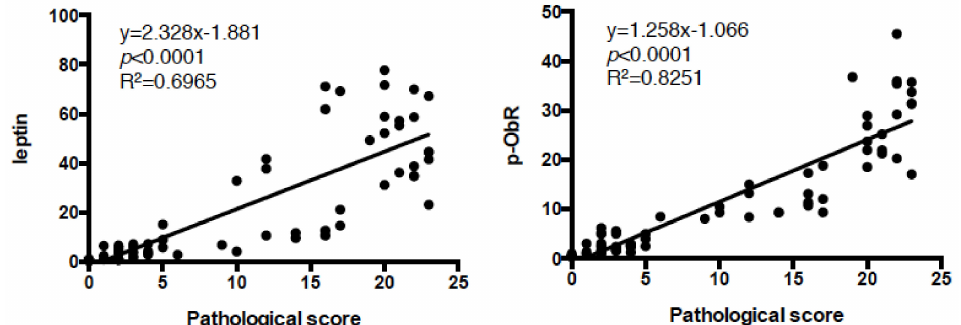
Figure 4. Highly correlation between pathogenesis and expression of leptin or p-ObR in the gastric mucosa of HFD-fed mice. Pearson correlation was performed for pathological score shown in Figure 2B and leptin or p-ObR expression shown in Figure 3B, and a significant correlation ( p < 0.0001) was obtained.